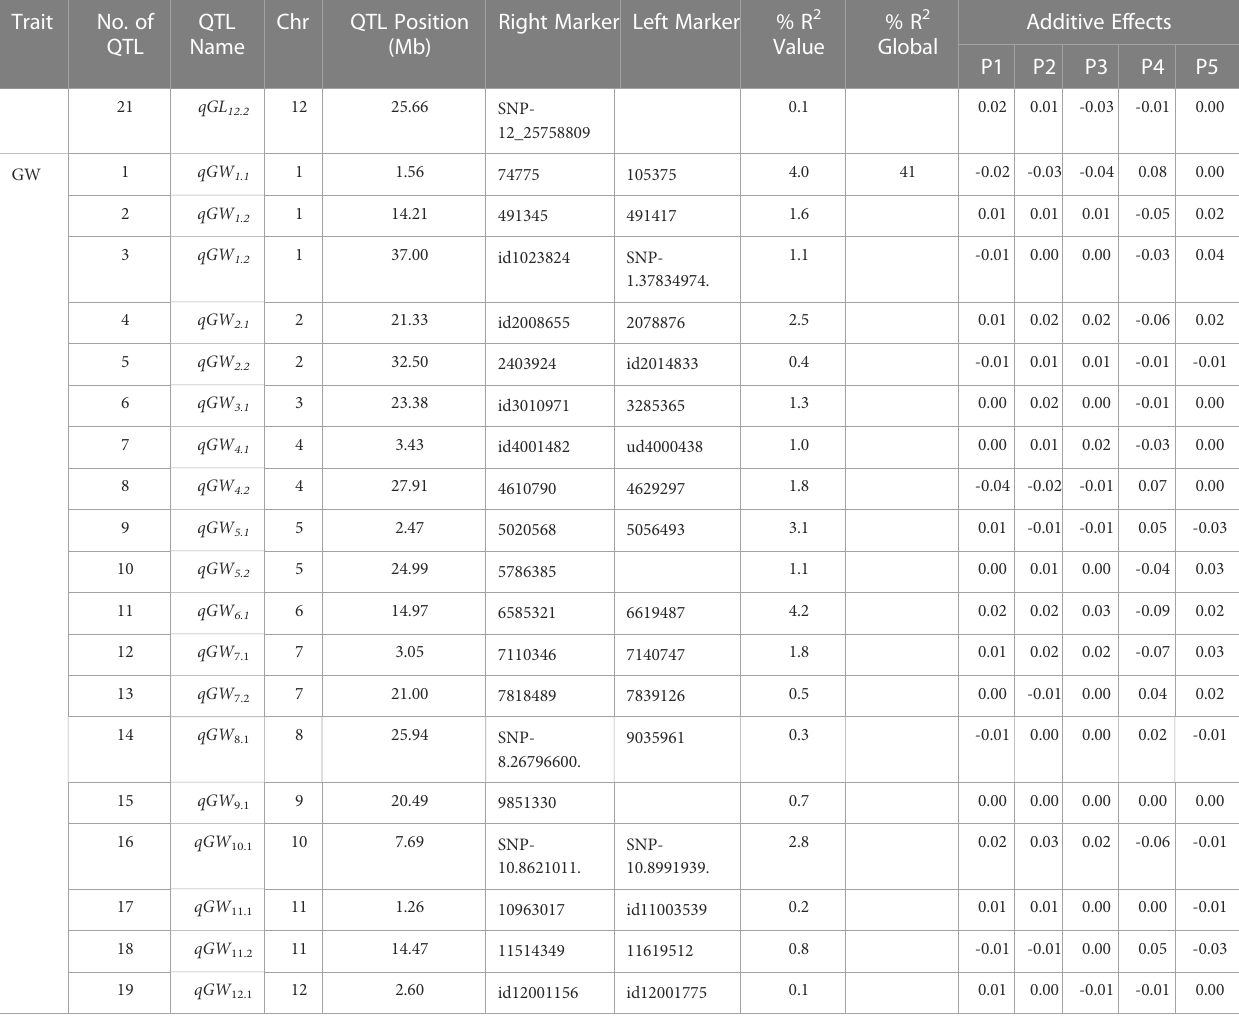
(Table 2). A major QTL ( qZn 5.2 ) with an R 2 of 13% was detected on chromosome 5 at 22.03 Mb fl anked by markers 5711540 and 5726844. It has a narrow genomic region of 600 Kb among the Zn QTLs. There were three QTLs, qZn 3.2 , qZn 11.1a and qZn 12.1b each R 2 ranging 0.7-3.2% and a global R 2 of 25%. These QTL were